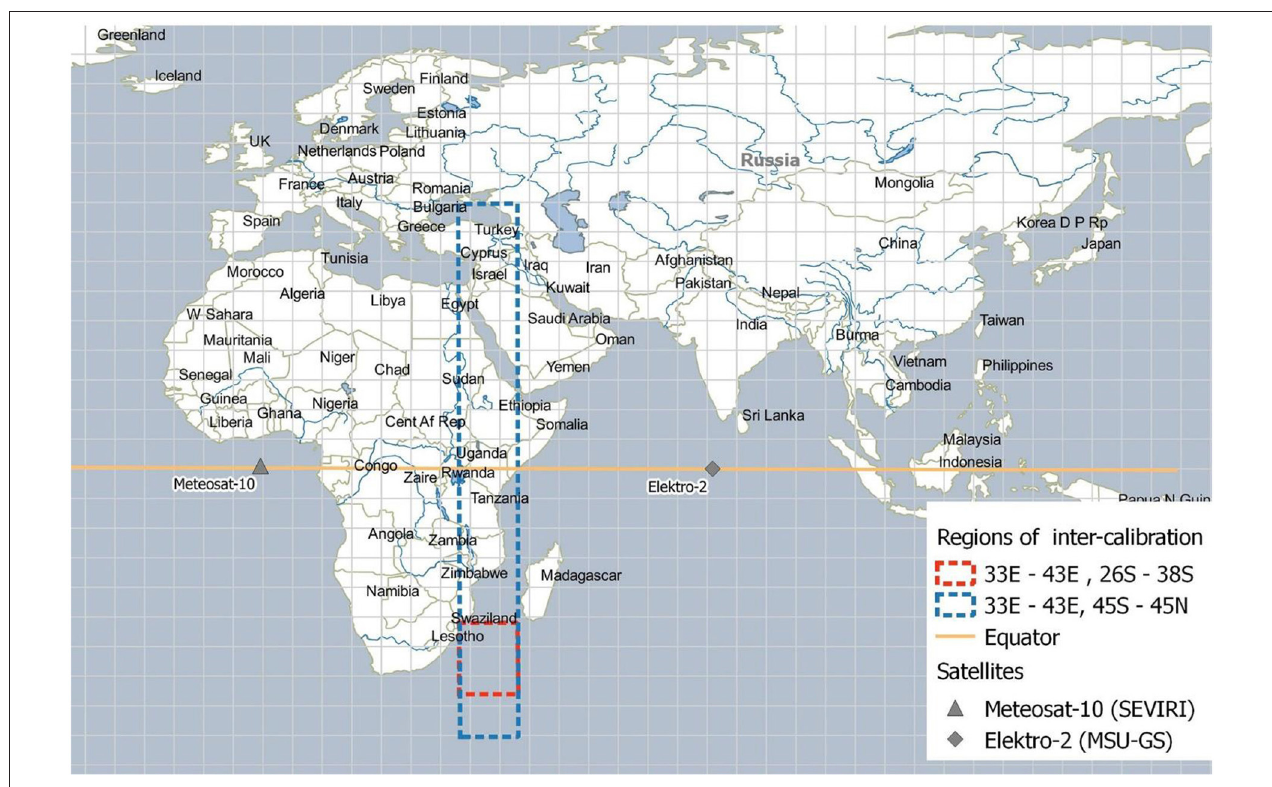
FIGURE 1 | Inter-calibration regions MSU-GS/Elektro-2 and SEVIRI/Meteosat-10.